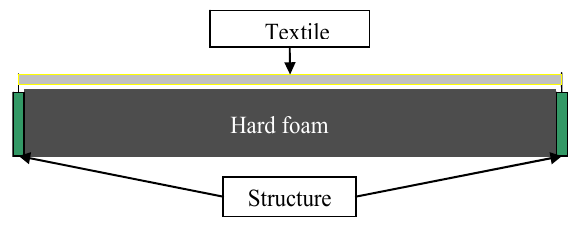
Figure 24. Diagram of the positioning of the foam.